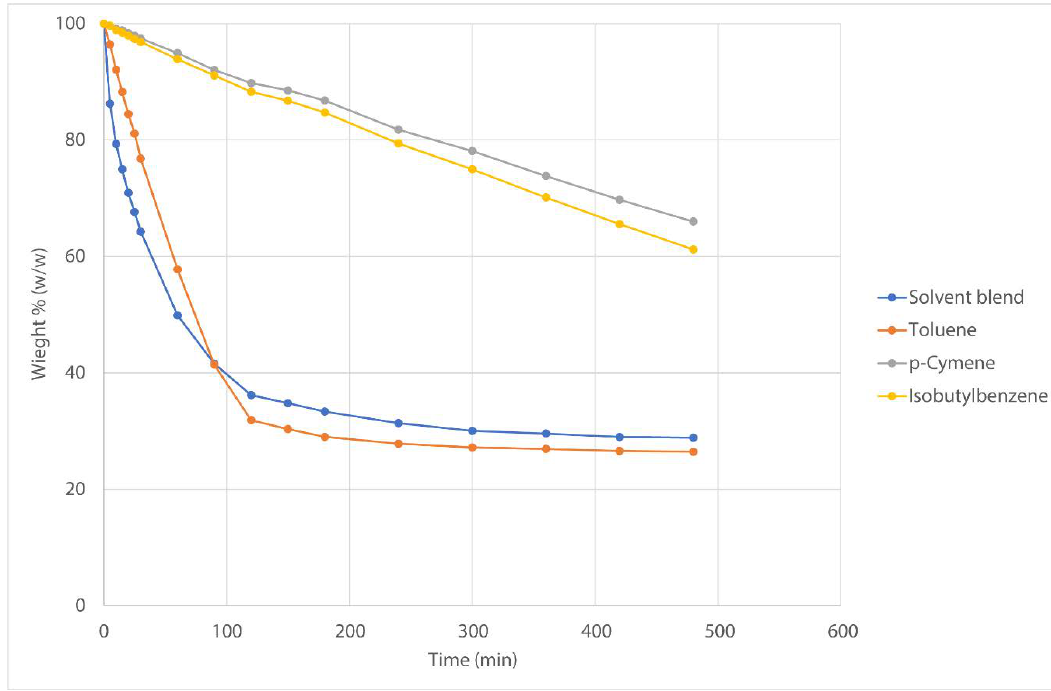
Figure 12. Evaporation rates for finished formulations for reference solvents and replacement solvents.